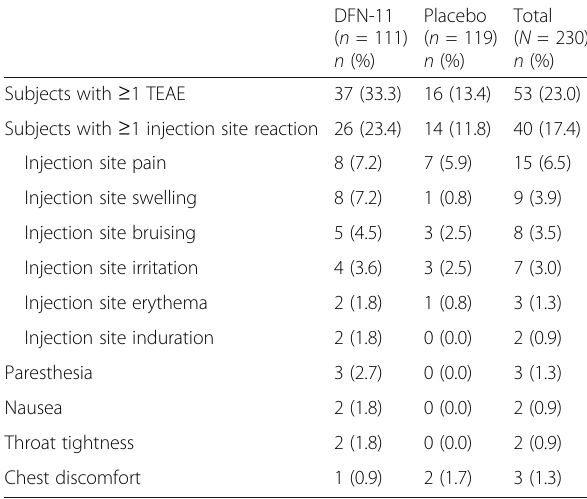
Table 2 Treatment-emergent adverse events overall and occurring in at least 2 subjects